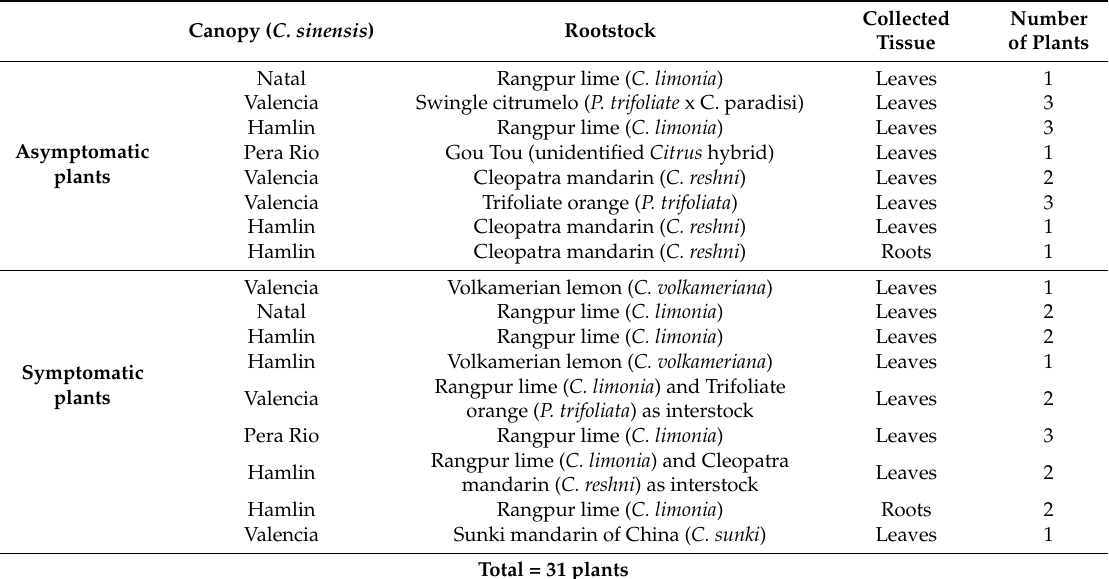
Table 1. Citrus plants used to assess the population of CSDaV. Canopy and rootstock genotypes of each plant are shown. Type of plant tissue and number of collected plants are indicated.